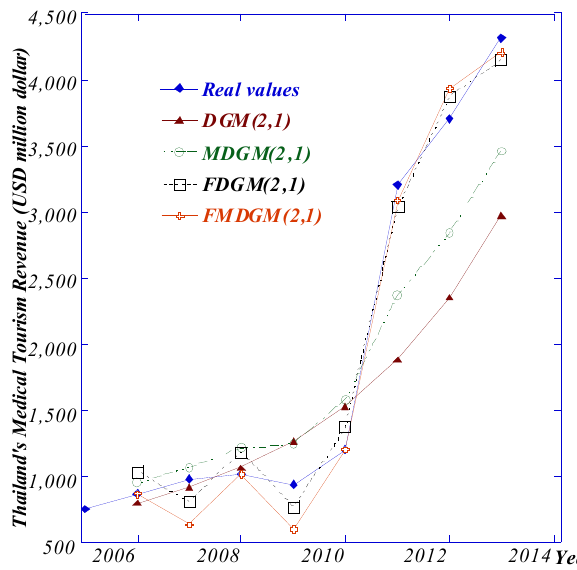
Figure 1. Comparison of the forecasting capability of different DGM(2,1) models for Thailand’s medical tourism revenue.